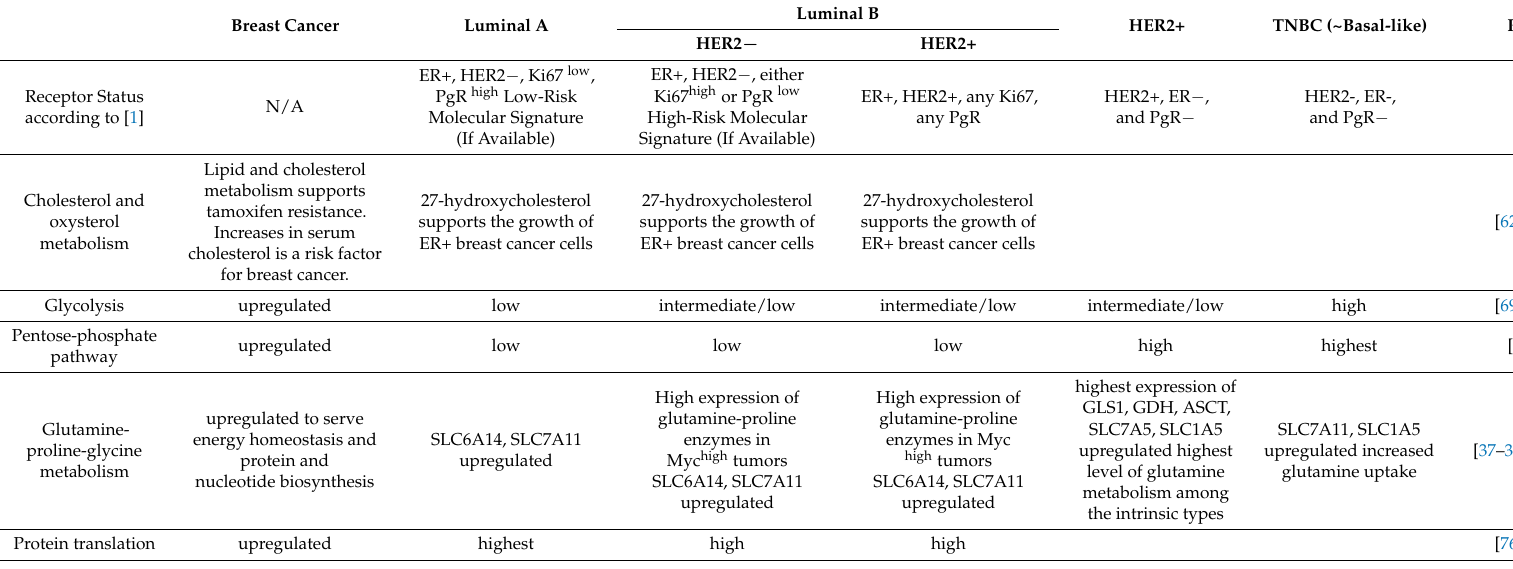
Table 1. Metabolic changes in the intrinsic subtypes of breast cancer. Empty squares stand for no data. Abbreviations: ASCT2/SLC1A5, amino acid transporter-2; ER, estrogen receptor; GDH/H6PD, glutamate dehydrogenase; GLS1, glutaminase 1; HER2, human epidermal growth factor 2 receptor; PgR, progesterone receptor; SLC, solute carrier